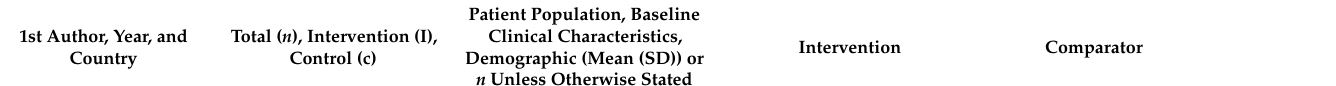
Table 2. A summary of the five papers reporting on four studies included in the